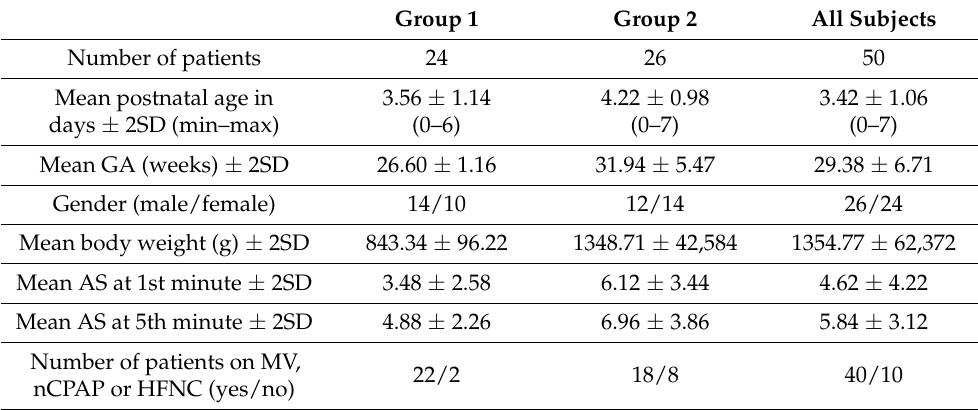
Table 1. Characteristics of the patients included in the study. Group 1 Group 2